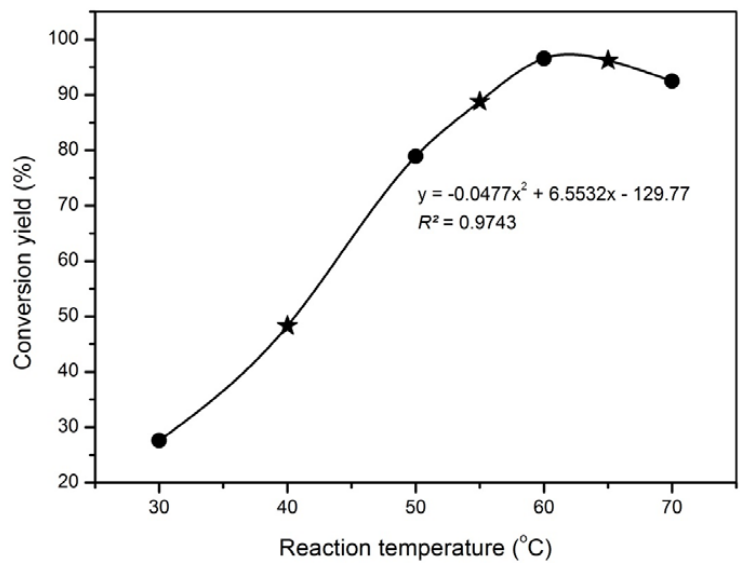
Figure 7. Effect of reaction temperature on biodiesel conversion yield at 1 wt % KOH catalyst concentration, continuous 750 rpm stirring speed for 60 min reaction time.